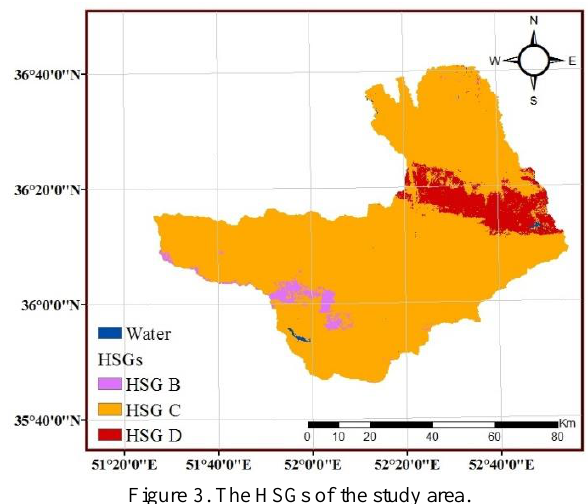
Figure 3. The HSGs of the study area.